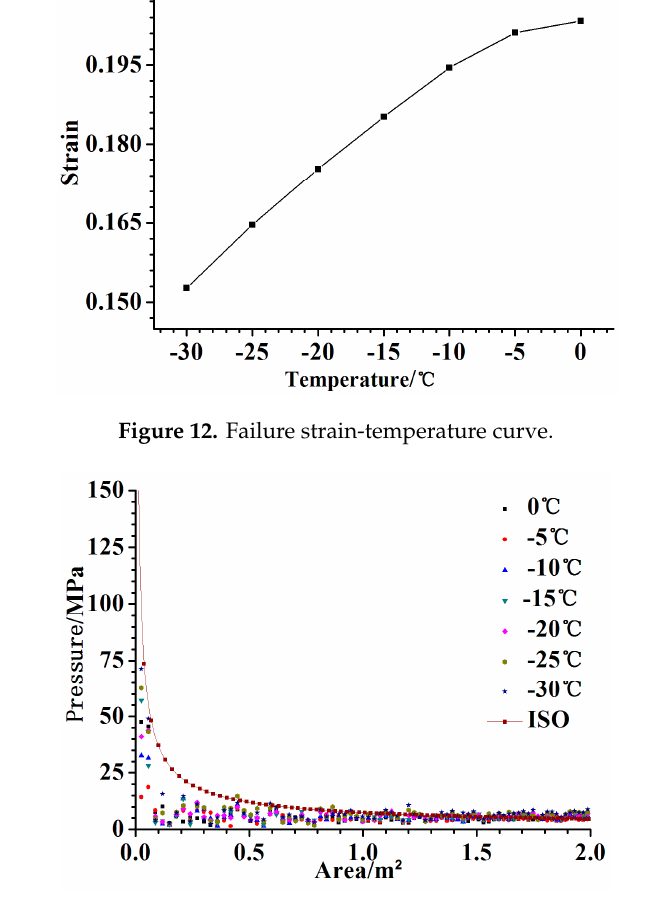
Figure 13. Pressure - area curves at different temperatures.